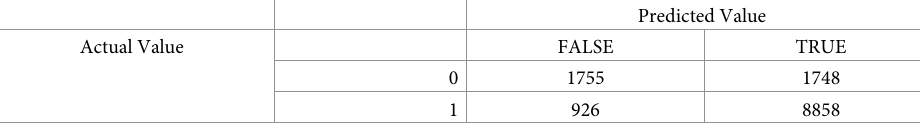
Table 4. Confusion matrix for the Leave Port model.